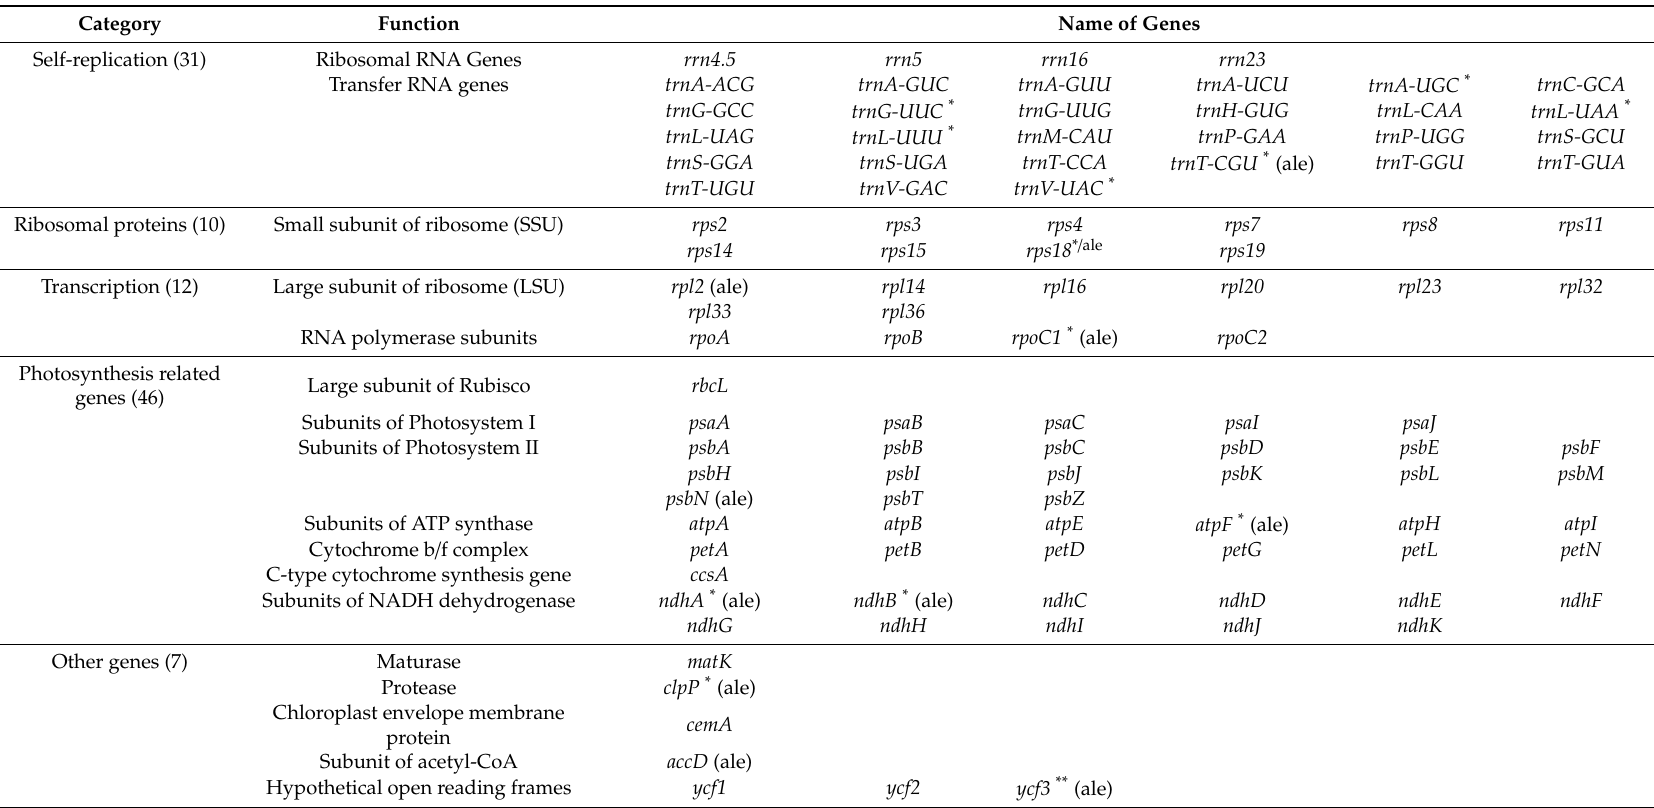
Table 2. List of genes annotated in the cp genomes of T. alexandrinum and T.